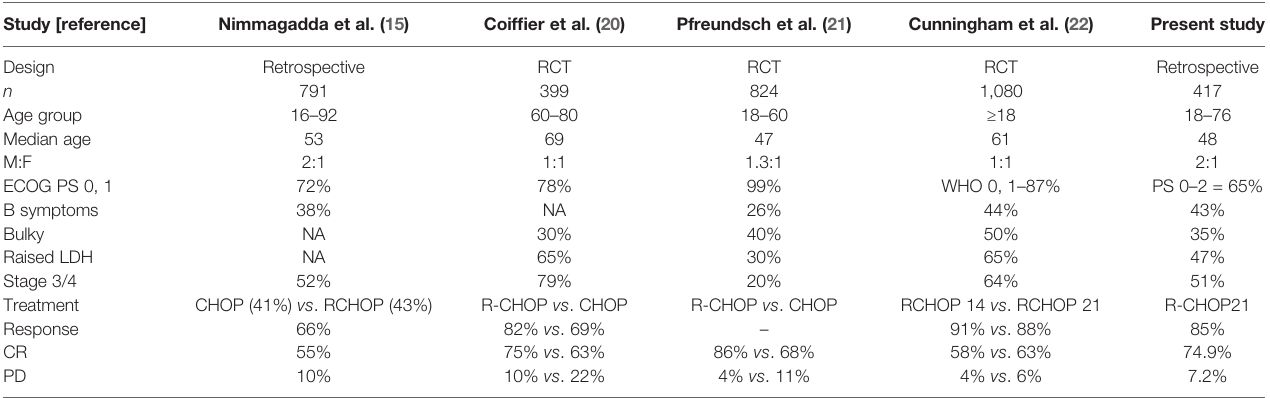
TABLE 3 | Comparative analysis of patient characteristics and response.